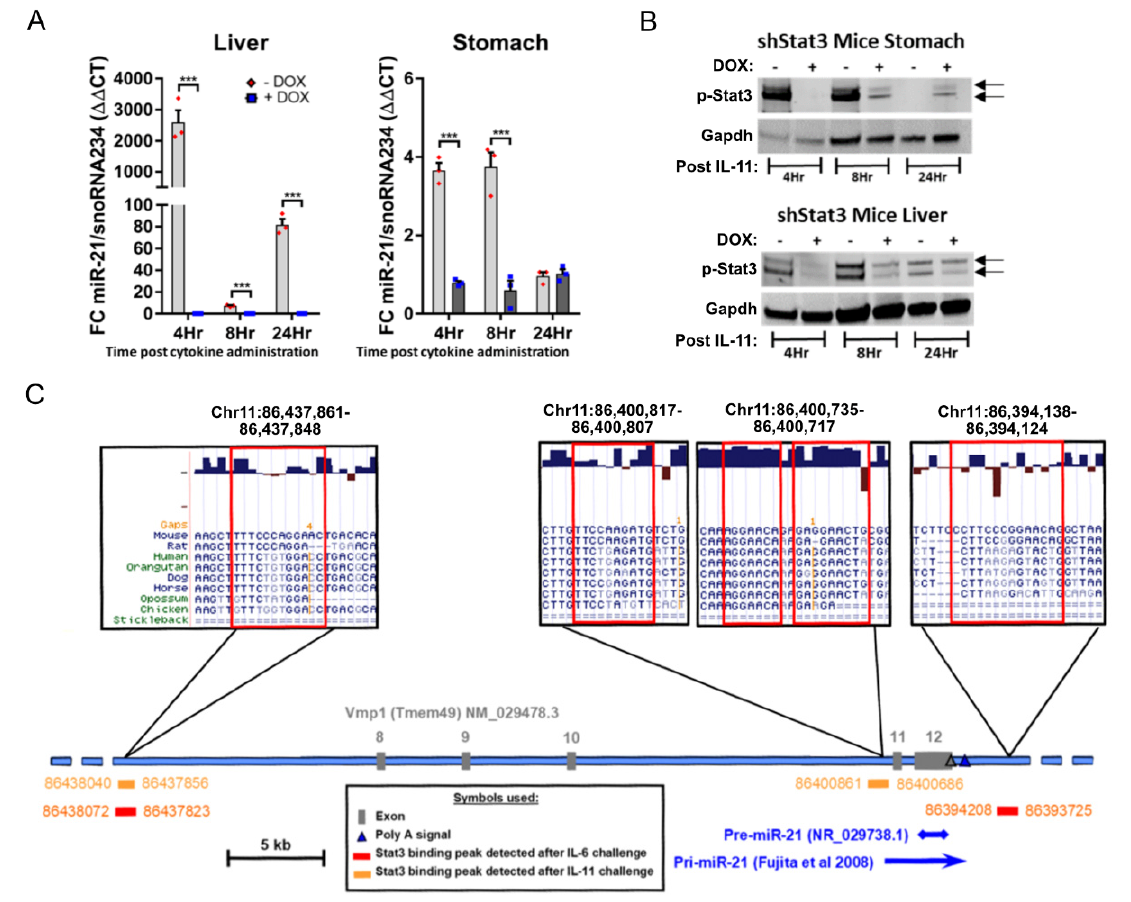
Figure 2. miR-21 is a direct transcriptional target of Stat3. ( A ) qRT-PCR TaqMan analysis of miR-21-5p expression in the liver and stomach of 6-week-old Gp130 F/F ; shStat3 ; rtTA mice injected with 5 µ g IL-11 cytokine. Where indicated, the mice were fed doxycycline (DOX)-containing food pellets for the previous 5 days to induce shStat3 expression. Each symbol represents an individual mouse, and the data are depicted as the mean ± SEM. n = 3 mice per group, *** p < 0.001. ( B ) Western blot analysis for p-Stat3 in liver and stomach tissue extracted 4, 8 or 24 h after the i.p. administration of 5 µ g IL-11 to shStat3 ; rtTA mice. Where indicated, the mice were fed DOX-containing food pellets, as in ( A ). Gapdh was used as a loading control. Each lane represents an individual mouse. ( C ) Representation of the murine Vmp1 gene locus containing the miR-21 gene on chromosome 11. As indicated in the boxed area above, there are three Stat3 binding peaks and a sequence near the pre-miR-21 start site identified by the Stat3 ChIP analysis performed on tumors isolated from 8-week-old Gp130 F/F mice 1 hr after a single i.p. injection of 5 µ g IL-6 or IL-11 to induce Stat3 signaling. The localizations of the IL-6 and IL-11-dependent Stat3 binding sites are indicated below the genomic locus in red and orange. The genome coordinates provided correspond to the C57Bl/6 mouse genome, NCBI build 37, 2007. The PhyloP conservation and genomic alignment data were retrieved using the UCSC Genome Browser (http://genome.ucsc.edu (accessed on 15 March